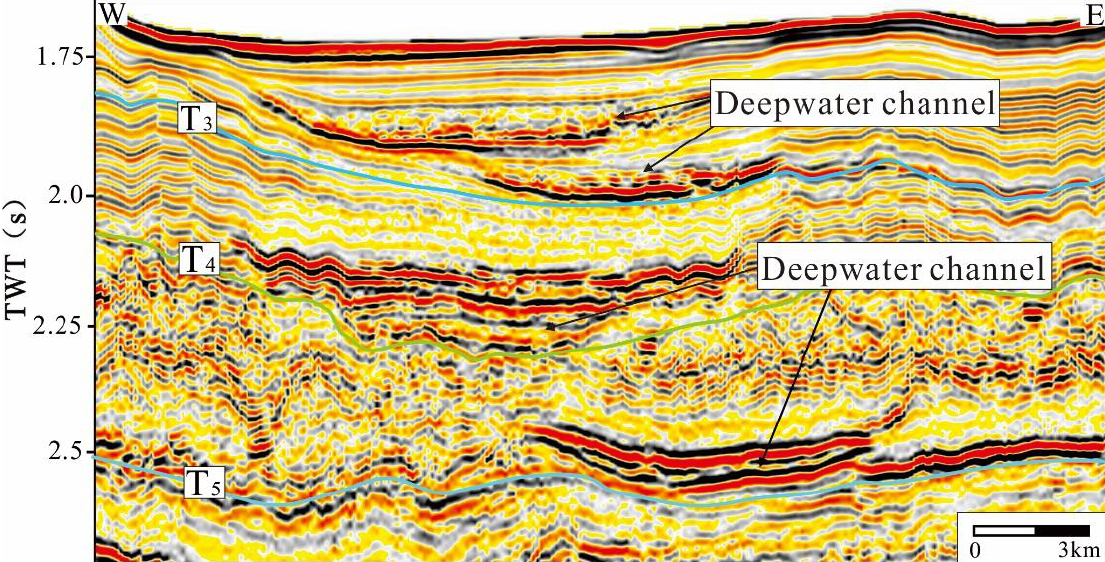
Figure 8. The seismic characteristics of deep-water channel of the Xisha carbonate platform. The location is shown in Figure 1B.